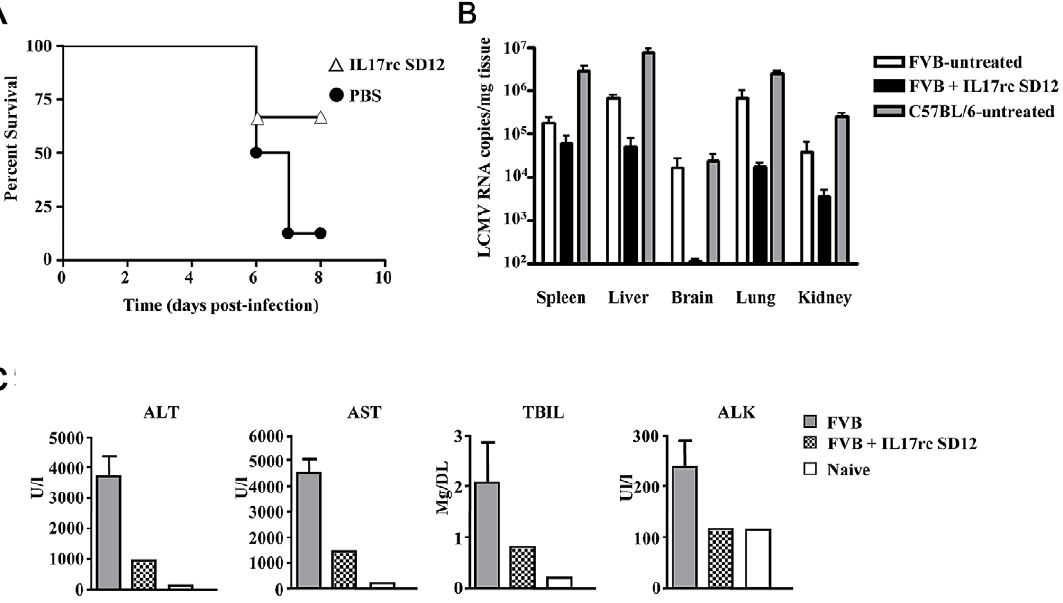
Figure 8. Blockade of the IL17 signaling pathway increases survival and reduces disease signs in LCMV infected FVB mice. FVB mice were infected with LCMV-13 and either treated with 7.5 mg/kg IL17RC SD12 antisense or PBS at days 0, 1, and 2 post-infection. A) Survival curves of PBS (n=8) and IL17RC SD12 (n=3) treated mice. B) Viral burden in tissues of FVB mice treated with PBS (n=8) or IL17RC SD12 (n=3). C) Clinical chemistry profiles of alanine aminotransferase (ALT), aspartate aminotransferase (AST), alkaline phosphatase (ALK), total bilirubin (TBIL) are presented. Untreated infected FVB data are presented as the mean + / 2 standard deviation of combined serum collected from three groups of 1–3 mice. Naı¨ve FVB and IL17RC SD12 treated data are presented as the values from combined serum collected from 3–5 mice.